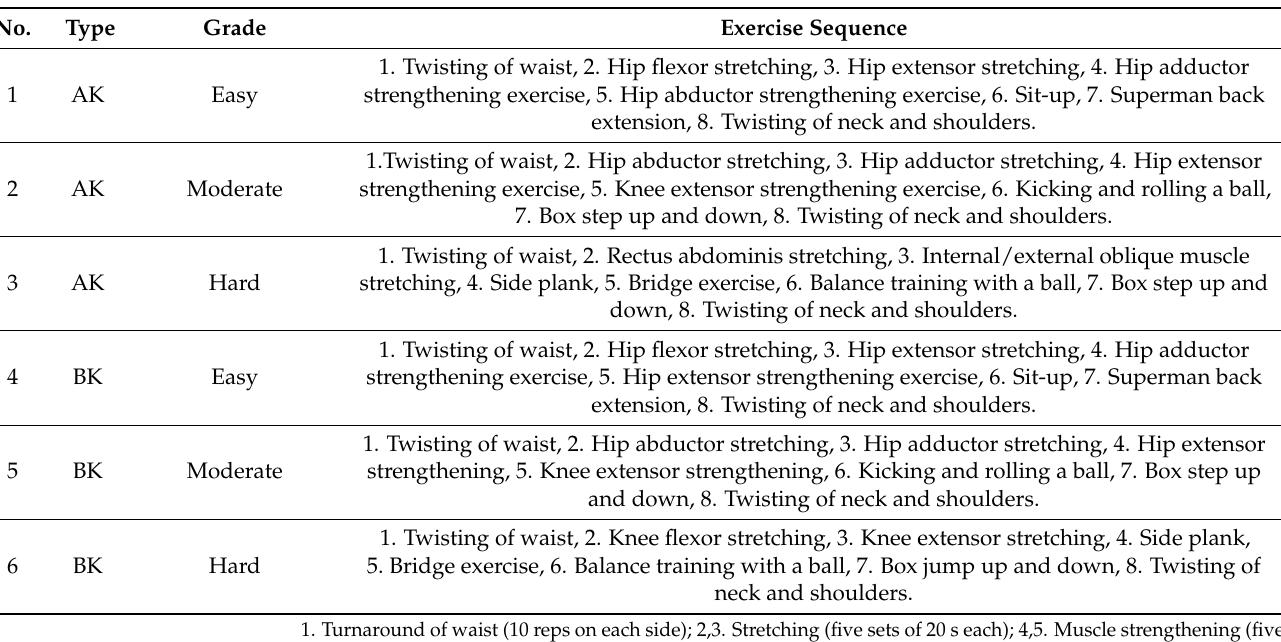
Table 1. Physical-strengthening exercises for lower-limb